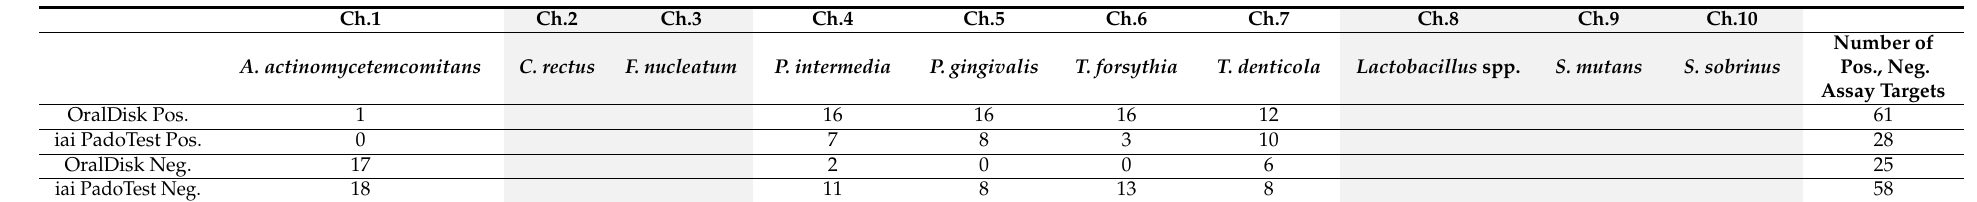
Table 2. Comparison between the iai PadoTest and the OralDisk. ‘Ch.1–Ch10’ refers to the numbering of the OralDisk chambers where each bacterium was detected. Grey shading denotes the bacteria that are not included in the iai PadoTest panel. ‘Pos.’ and ‘Neg.’ are abbreviations for ‘positive’ and ‘negative’,